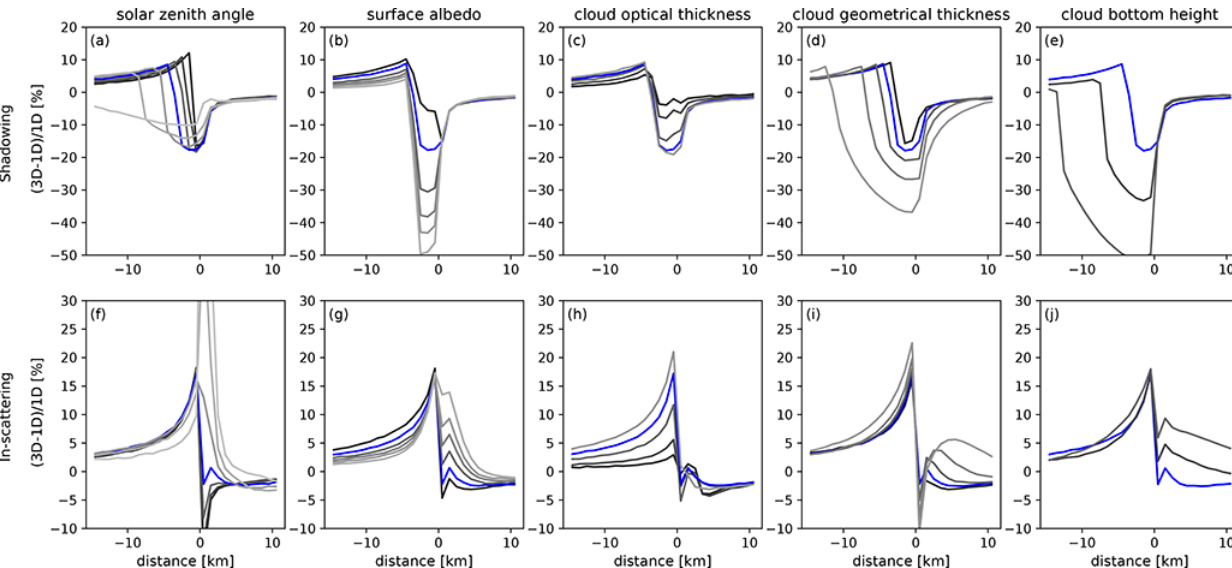
Figure 5. Relative difference between 3D and 1D reflectance at 460nm for the liquid water cloud at 2–3km altitude. Negative distances from the cloud edge correspond to pixels in the clear region and positive differences to pixels in the cloudy region of the domain. The individual columns are for the parameters defined in Table 1; see also the panel titles. The upper row (a–e) is for the cloud shadow and the lower row (f–j) for in-scattering by the cloud. The blue line in each figure corresponds to the base case, and the other lines correspond to the parameter range as in Table 1, starting from the lowest value in black to the highest value in grey.